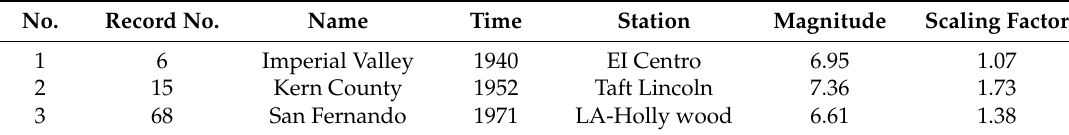
Table 2. Earthquake records used in time history analysis.